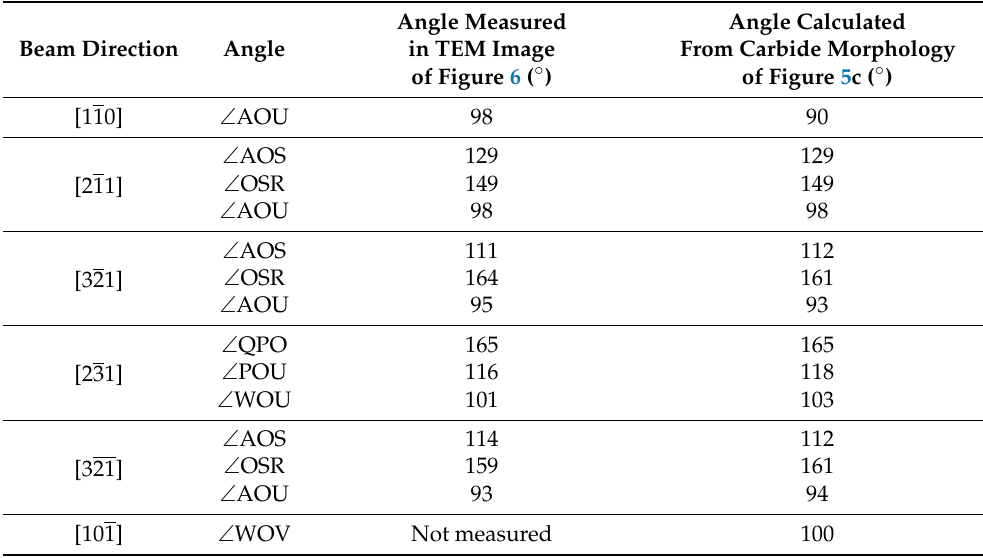
Table 5. The angle measured in TEM carbide images in Figure 6 and that calculated from the carbide morphology in Figure 5c with beam